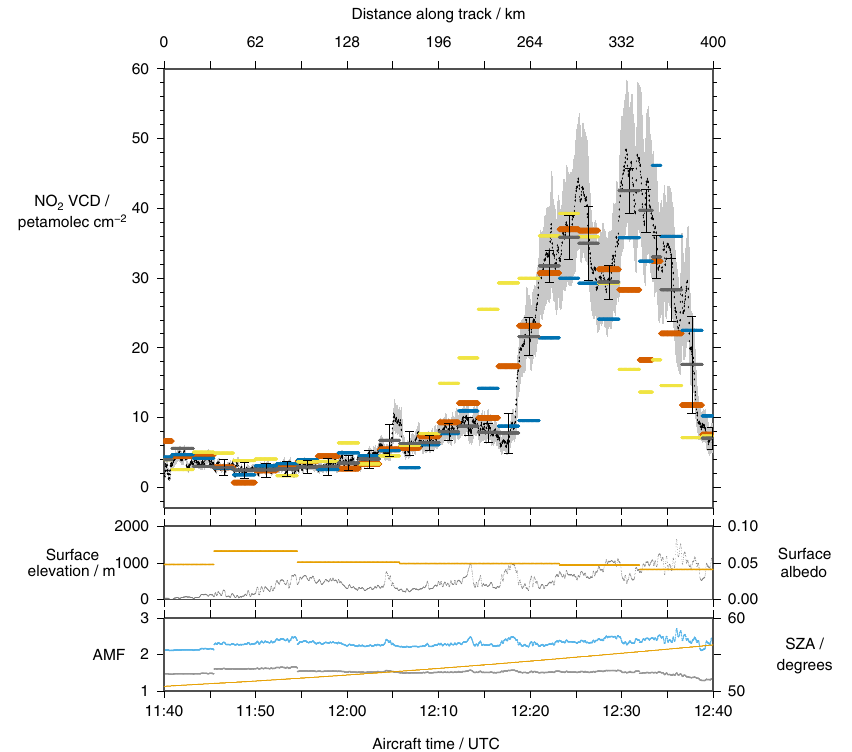
Figure 13. A time series of the airborne DOAS NO 2 vertical column densities on 11 August 2007, DOMINO V2.0 at aircraft nadir (orange) and one OMI line west (blue) and east (yellow). Aircraft measurements averaged over the length of each OMI pixel are shown in grey. Sub-plots are as described for Fig.